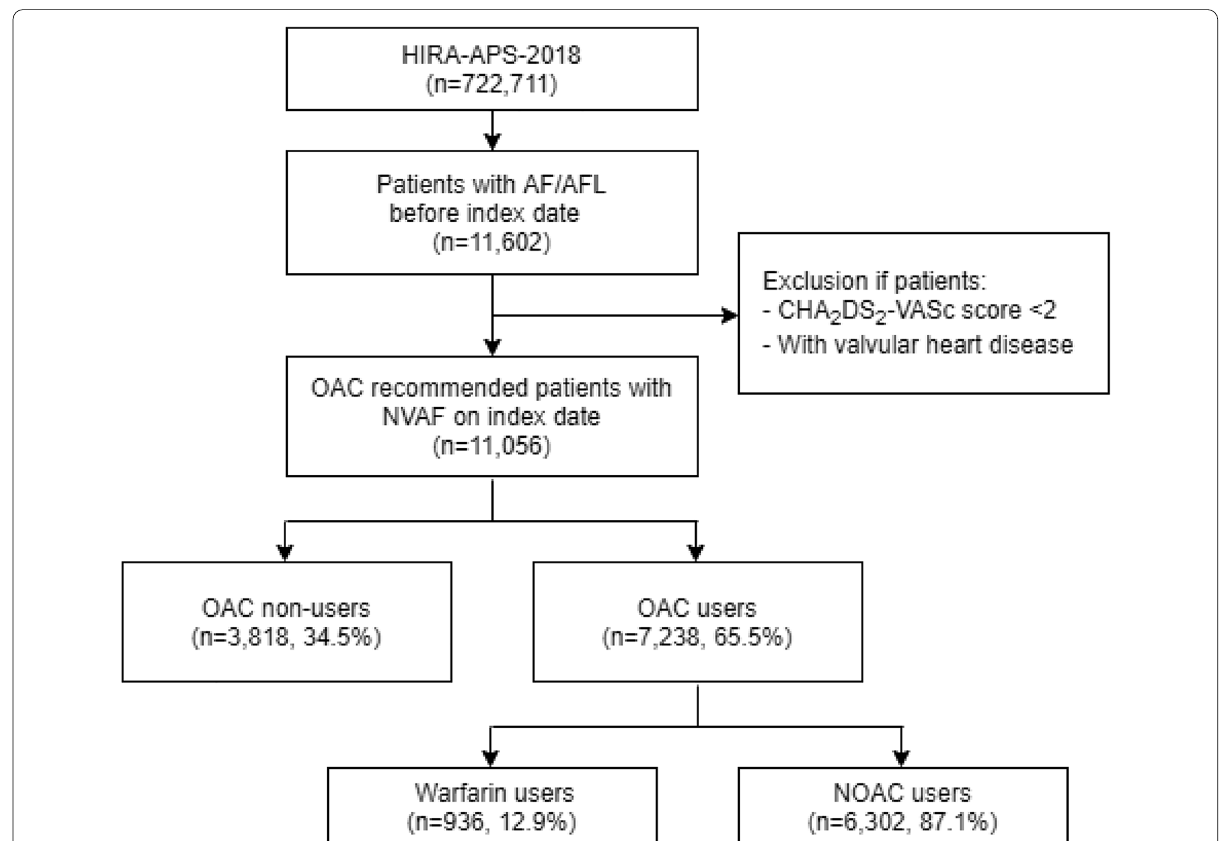
Fig. 1 Extraction of study subject. AF, atrial fibrillation; AFL, atrial flutter; CHA 2 DS 2 -VASc, congestive heart failure, hypertension, age of [doubled], diabetes mellitus, prior stroke or transient ischemic attack [TIA] [doubled], vascular disease, age of 65 to 74 years, and sex; HIRA-APS, Health Insurance Review & Assessment Service-Aged Population Sample; NOAC, non-vitamin K antagonist oral anticoagulant; NVAF, nonvalvular atrial fibrillation; OAC, oral